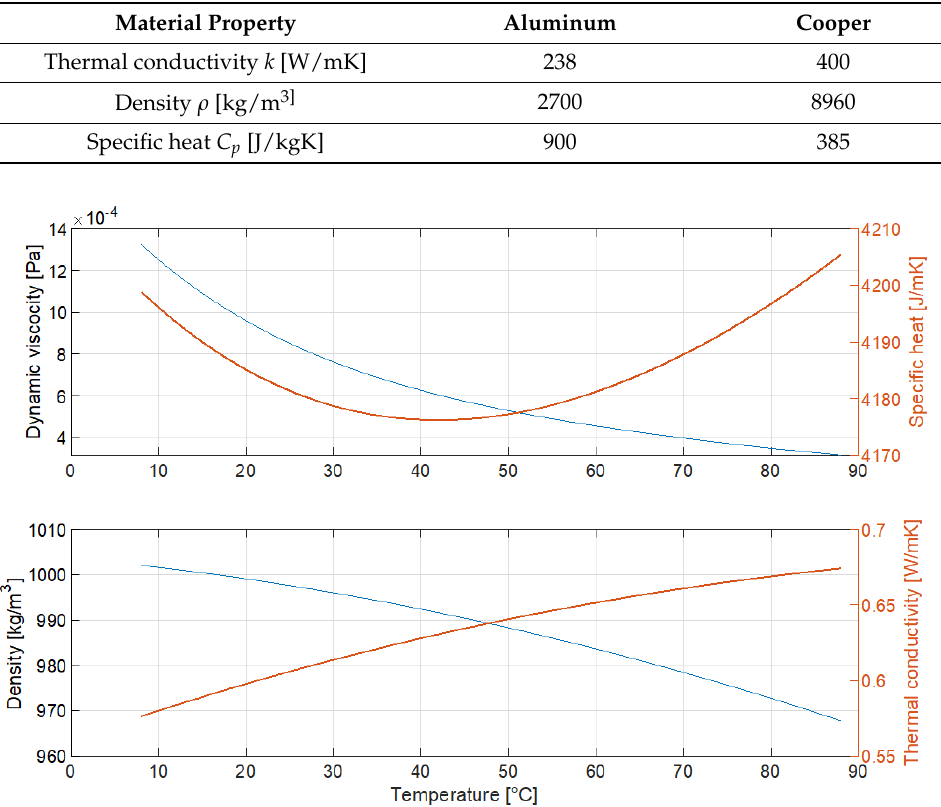
Figure 9. Air thermal properties. To take into consideration the velocity changes for different geometries during the parametric study, the velocity for each parameter set is calculated considering a constant volumetric flow. Model geometry for a given parameter set value is calculated through the formulas given in Table 3. This type of geometric model setup allows the easy implementation of paremetric studies without constant supervision of COMSOL or having to run each simulation separately.